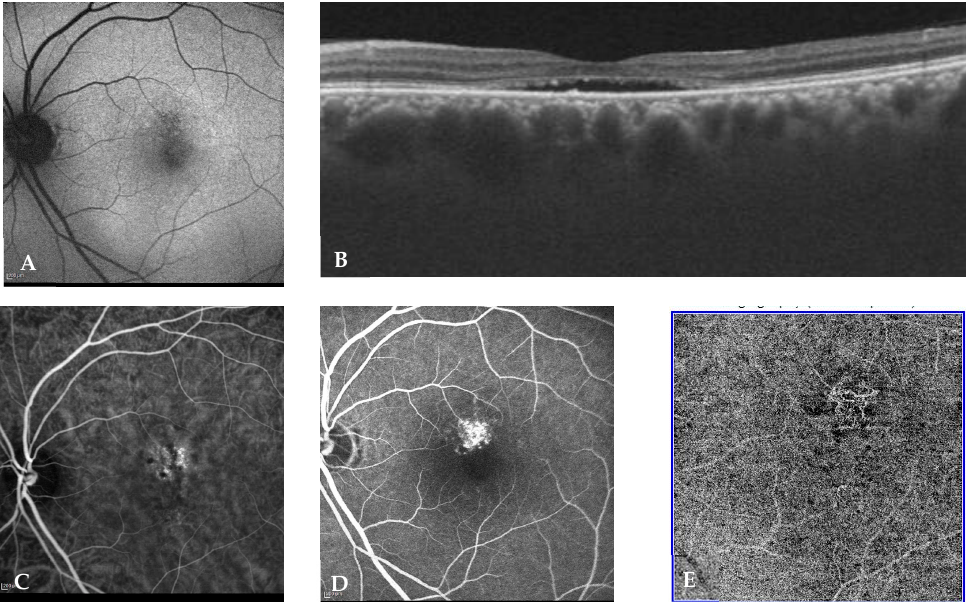
Figure 1. Eye of a 52-year-old male with a visual acuity of 20/20 and metamorphopsia for 4 months ( A ) shows <1–2 DD of RPE abnormality (simple CSCR) ( B ) OCT (B scan) passing through the fovea shows subretinal fluid along with flat irregular pigment epithelium detachment suspicious of CNV ( C ), ( D , E ) show ICG-A, FA and OCTA, respectively, all of which confirm the choroidal neovascular complex.